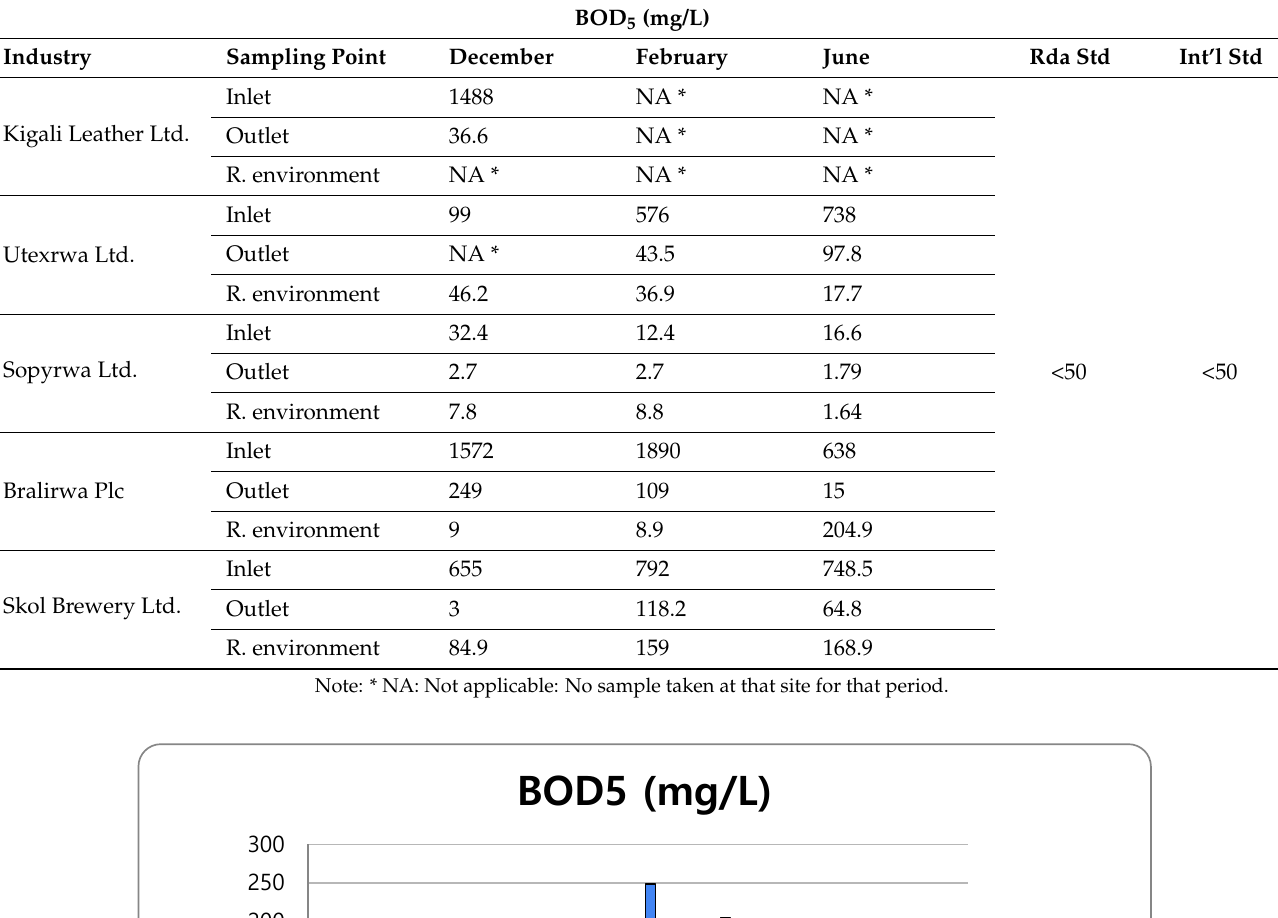
Table 3. BOD 5 results for the selected industries.